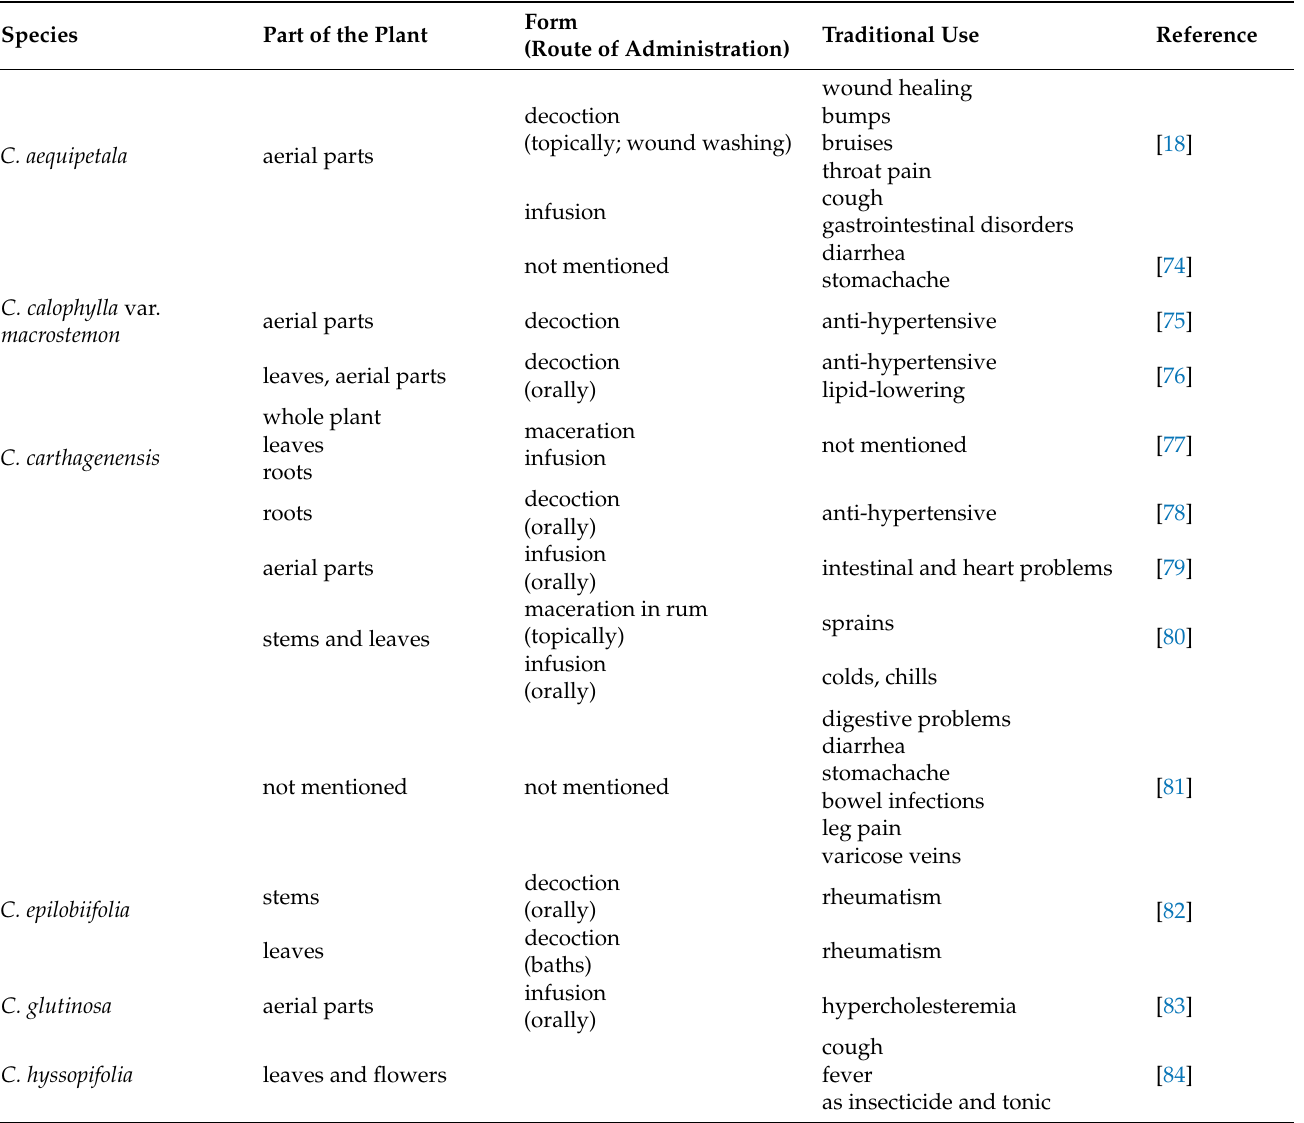
Table 3. Medicinal uses of Cuphea